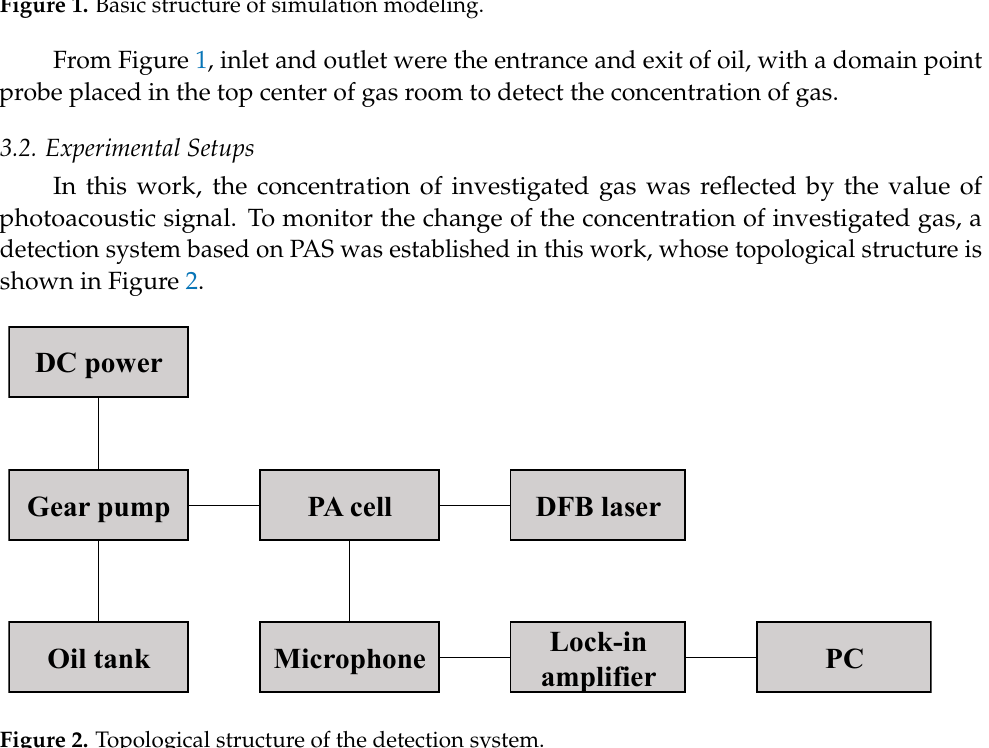
Figure 2. Topological structure of the detection system.